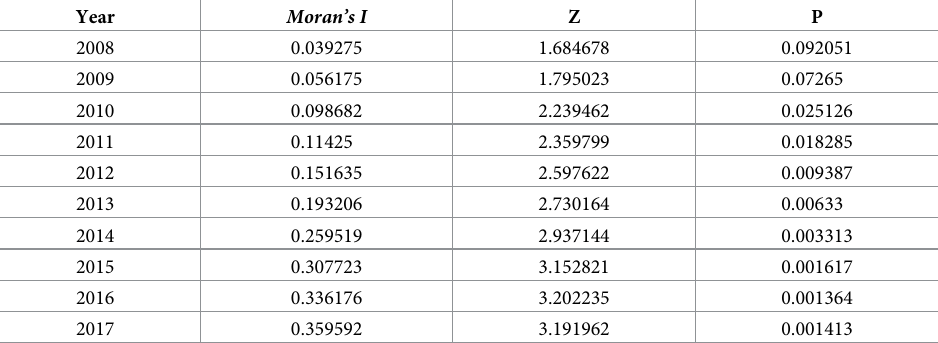
Table 3. Global spatial correlation test